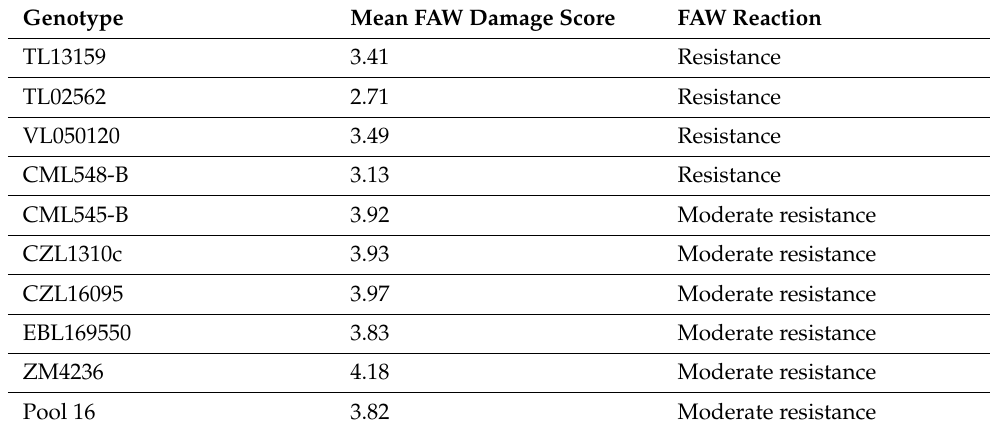
Table 11. Mean damage scores and FAW reactions for promising genotypes identified in the